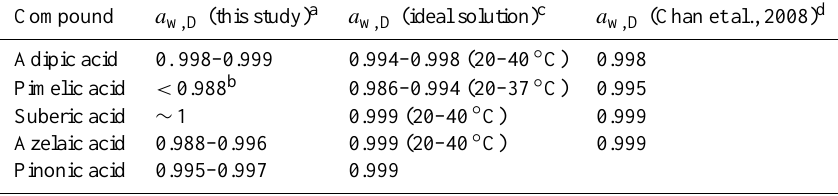
Table 4. Values of water activity a w,D of deliquescence based on CCN activation data. Data from Chan et al. (2008) are listed for